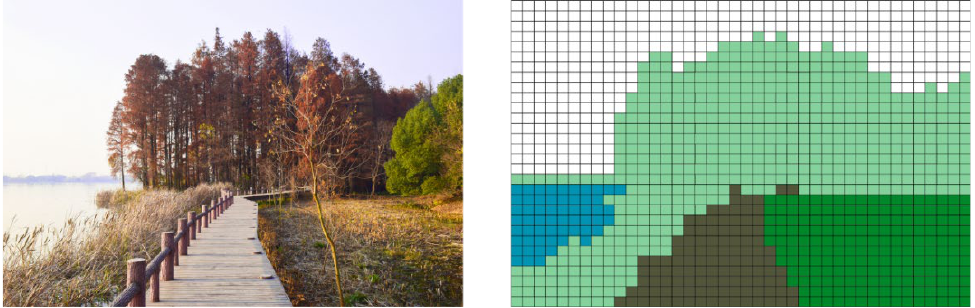
Figure 2. The extraction of environmental elements from the sample photo. Blue = water space; white = sky; gray = pavement; light green = trees and shrubs; dark green = lawn.